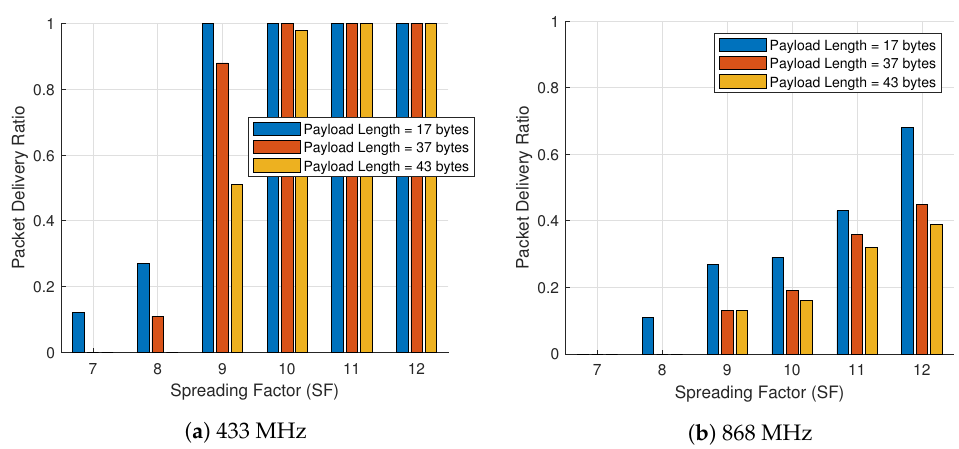
Figure 10. PDR vs. SF in POS 2 with CR = 4/5, BW = 125 KHz for ( a ) 433 MHz band ( b ) 868 MHz band.